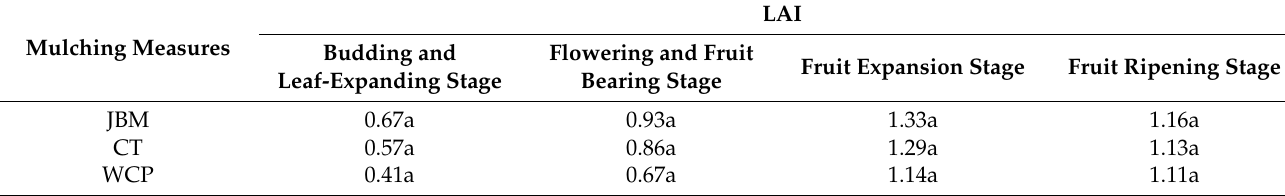
Table 4. Changes in LAI at different growth stages under different mulching measures during the 2014 jujube growing season.